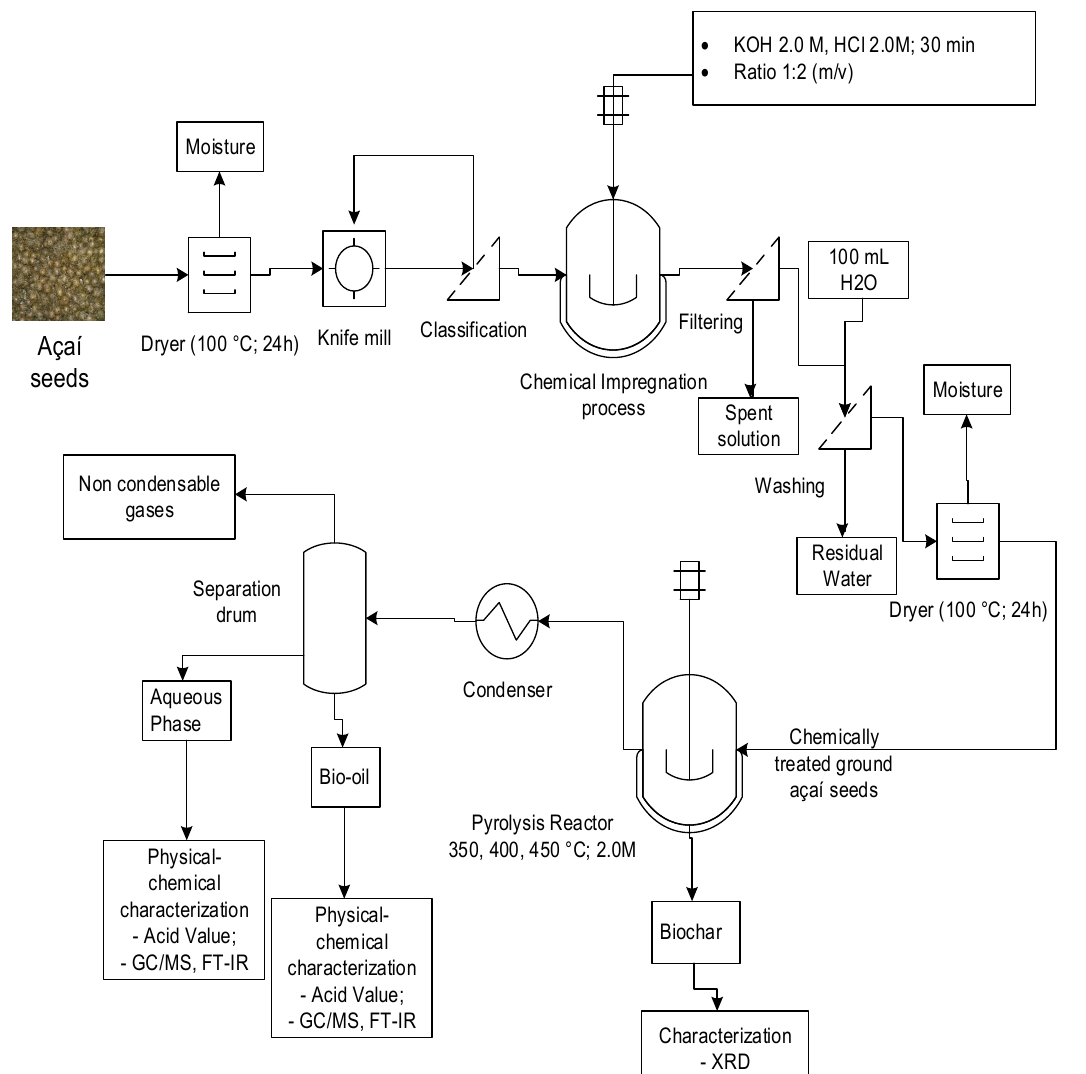
Figure 1. Process flow schema of bio-oil production by pyrolysis of Açaí seeds at 350, 400, and 450 °C, 1.0 atm, activated with 2.0 M KOH and HCl, using a fixed bed reactor, in laboratory scale.